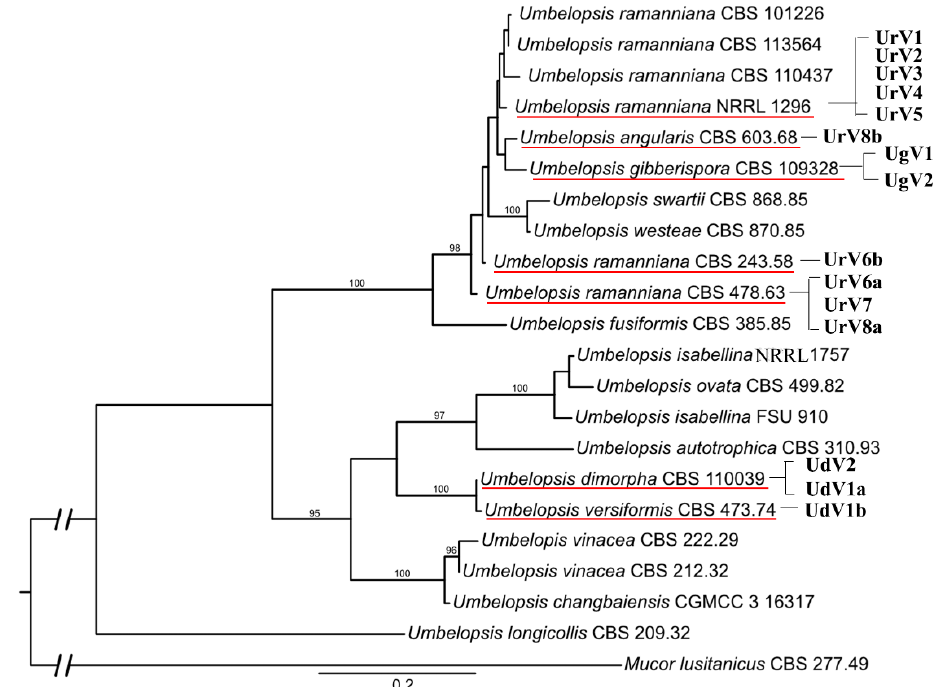
Figure 6. Comparison of the phylogeny of the tested Umbelopsis species inferred from the ITS and MCM7 sequences. Model testing was performed on the partitioned dataset using the built-in model selection software of IQ-TREE v. 1.6.12. Bootstrap values (%) indicated on branches were obtained with 5000 replicates. Mucor lusitanicus CBS 277.49 was used as the outgroup. Virus-carrying isolates have been marked with a red underline. UrV1, Umbelopsis ramanniana virus 1; UrV2, Umbelopsis ramanniana virus 2; UrV3, Umbelopsis ramanniana virus 3; UrV4, Umbelopsis ramanniana virus 4; UrV5, Umbelopsis ramanniana virus 5; UrV8b, Umbelopsis ramanniana virus 8b; UgV1, Umbelop- sis gibberispora virus 1; UgV2, Umbelopsis gibberispora virus 2; UrV6b, Umbelopsis ramanniana virus 6b; UrV6a, Umbelopsis ramanniana virus 6a; UrV7, Umbelopsis ramanniana virus 7; UrV8a, Umbelopsis ramanniana virus 8a; UdV2, Umbelopsis dimorpha virus 2; UdV1a, Umbelopsis dimor- pha virus 1a; UdV1b, Umbelopsis dimorpha virus 1b. 3.6. Detection of Virus Particles in the Virus-Harboring Umbelopsis Strains The presence of virus-like particles (VLPs) in U. ramanniana NRRL 1296 was already reported [4]. In this study, transmission electron microscopy revealed the presence of iso- metric VLPs in the purified extracts of the other five mycovirus-harboring Umbelopsis strains (Figure 7). VLPs about 32 nm in diameter were detected in U. ramanniana CBS 478.63 and CBS 243.58, U. gibberispora CBS 109328 and U. angularis CBS 603.68, while the VLPs in U. versiformis CBS 473.74 proved to be about 31 nm in diameter. VLPs could not be detected in the U. dimorpha CBS 110039 strain.